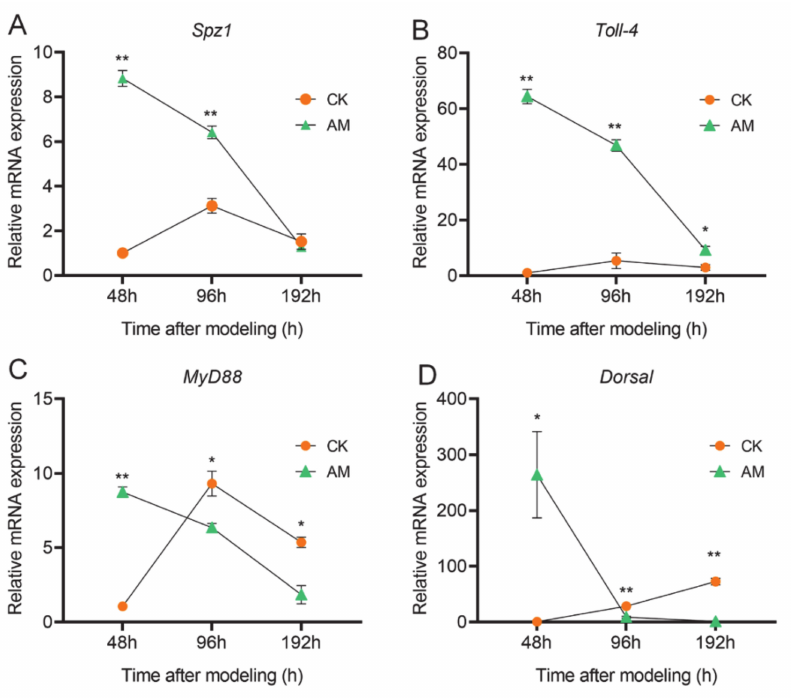
Figure 5. High PPC affected Toll signaling pathway genes expression. The mRNA levels of ( A ) Spz1 and ( B ) Toll-4 and ( C ) Myd88 and ( D ) Dorsal genes in hemocytes detected by qRT-PCR. * p < 0.05; ** p < 0.01. Mean ± SEM. n =